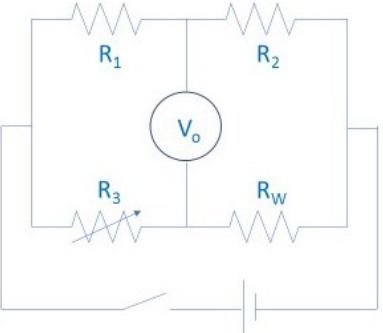
Figure 6. Hot transient wire scheme.